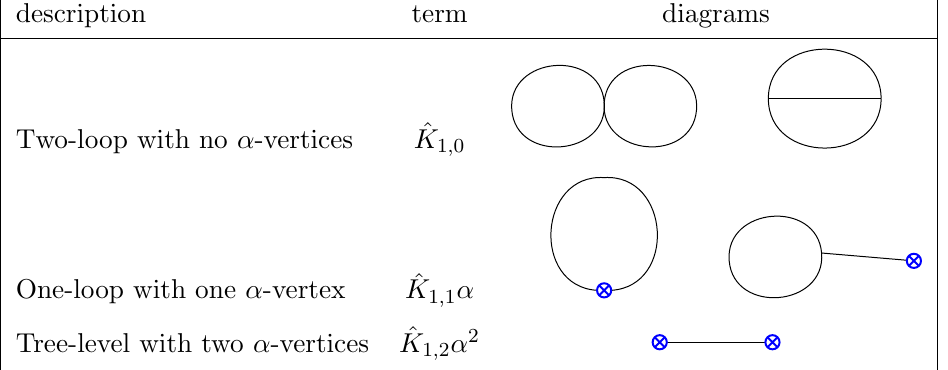
Table 1 . Diagrams appearing at order 1 =